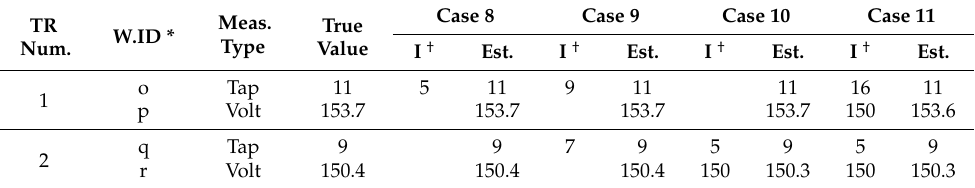
Table 10. Results of the bad data processing for Scenario C. TR Num.